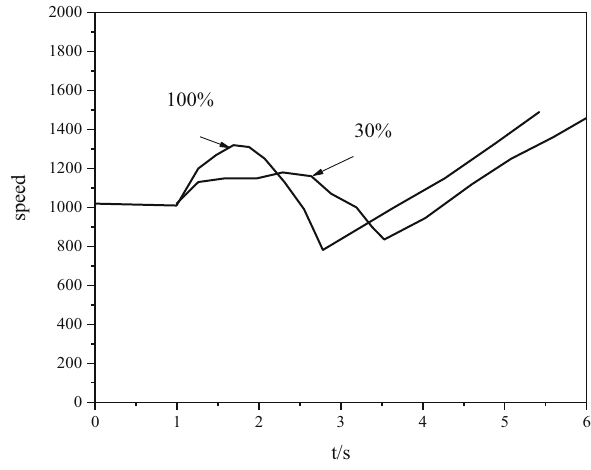
Figure 3: Simulation of emergency and normal startup